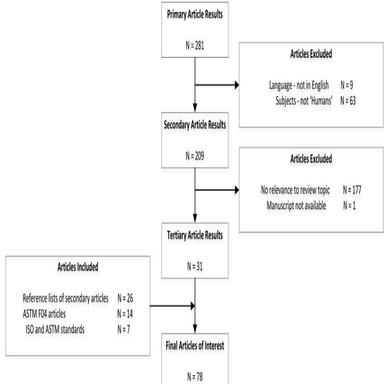
Flow chart summarising inclusion and exclusion of articles following application of the search strategy.